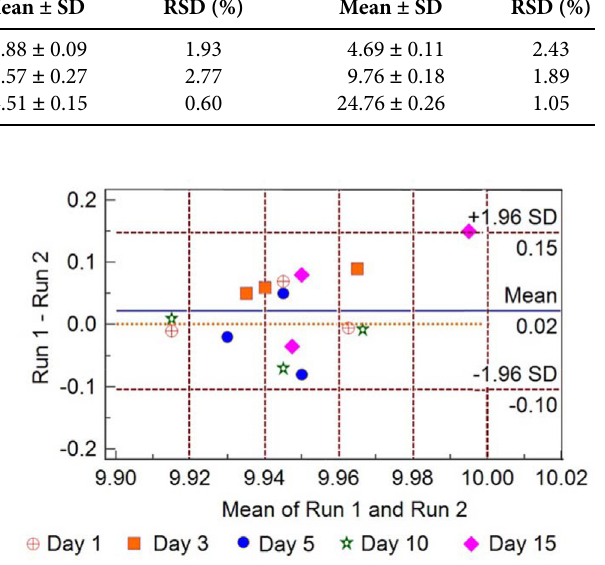
Table 5. Stability of curcumin in rat plasma at different conditions (n = 3) Concentration